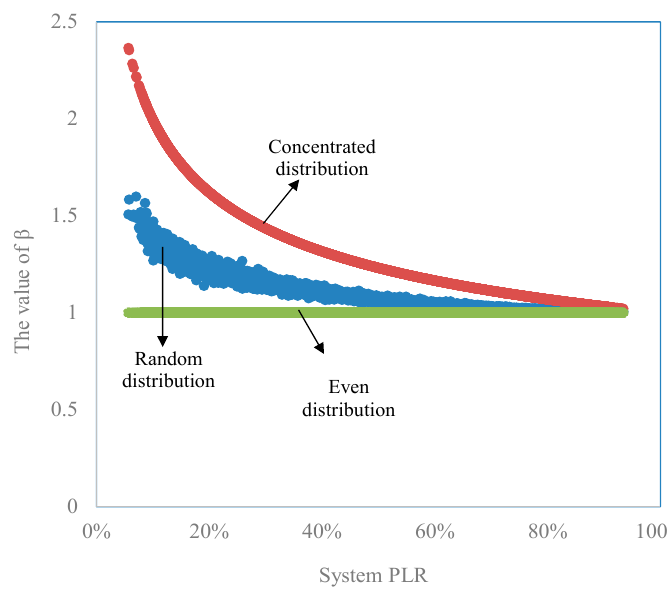
Figure 3. The value of β (coupling effect) under three types of load distribution conditions.